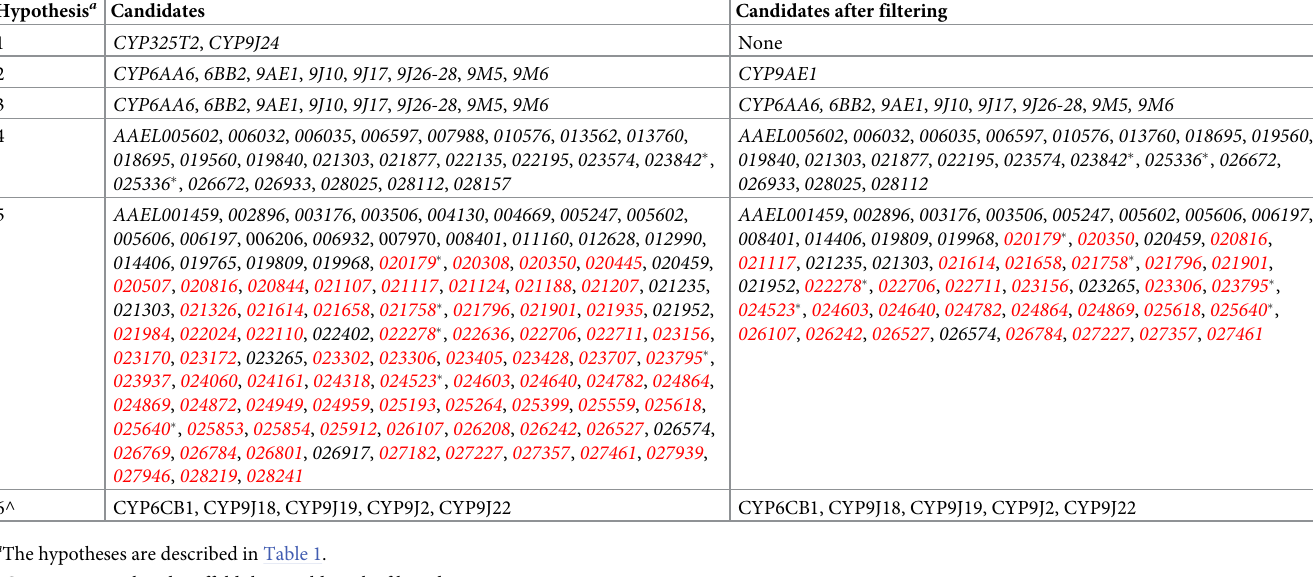
Table 5. List of factors potentially responsible for CYP-mediated resistance in SP identified by RNA-seq and proteomic analyses. The hypotheses are explained in Table 1. Genes were put into the final column if their position in the genome was consistent with the mapped resistance loci (40Mb-250Mb and 300Mb-310Mb in chromo- some 1; 310Mb-320Mb and 330Mb-360Mb in chromosome 3, Fig 3). The VectorBase accession numbers for the CYPs are shown in S18 Table. Red numbers indicate lncRNAs